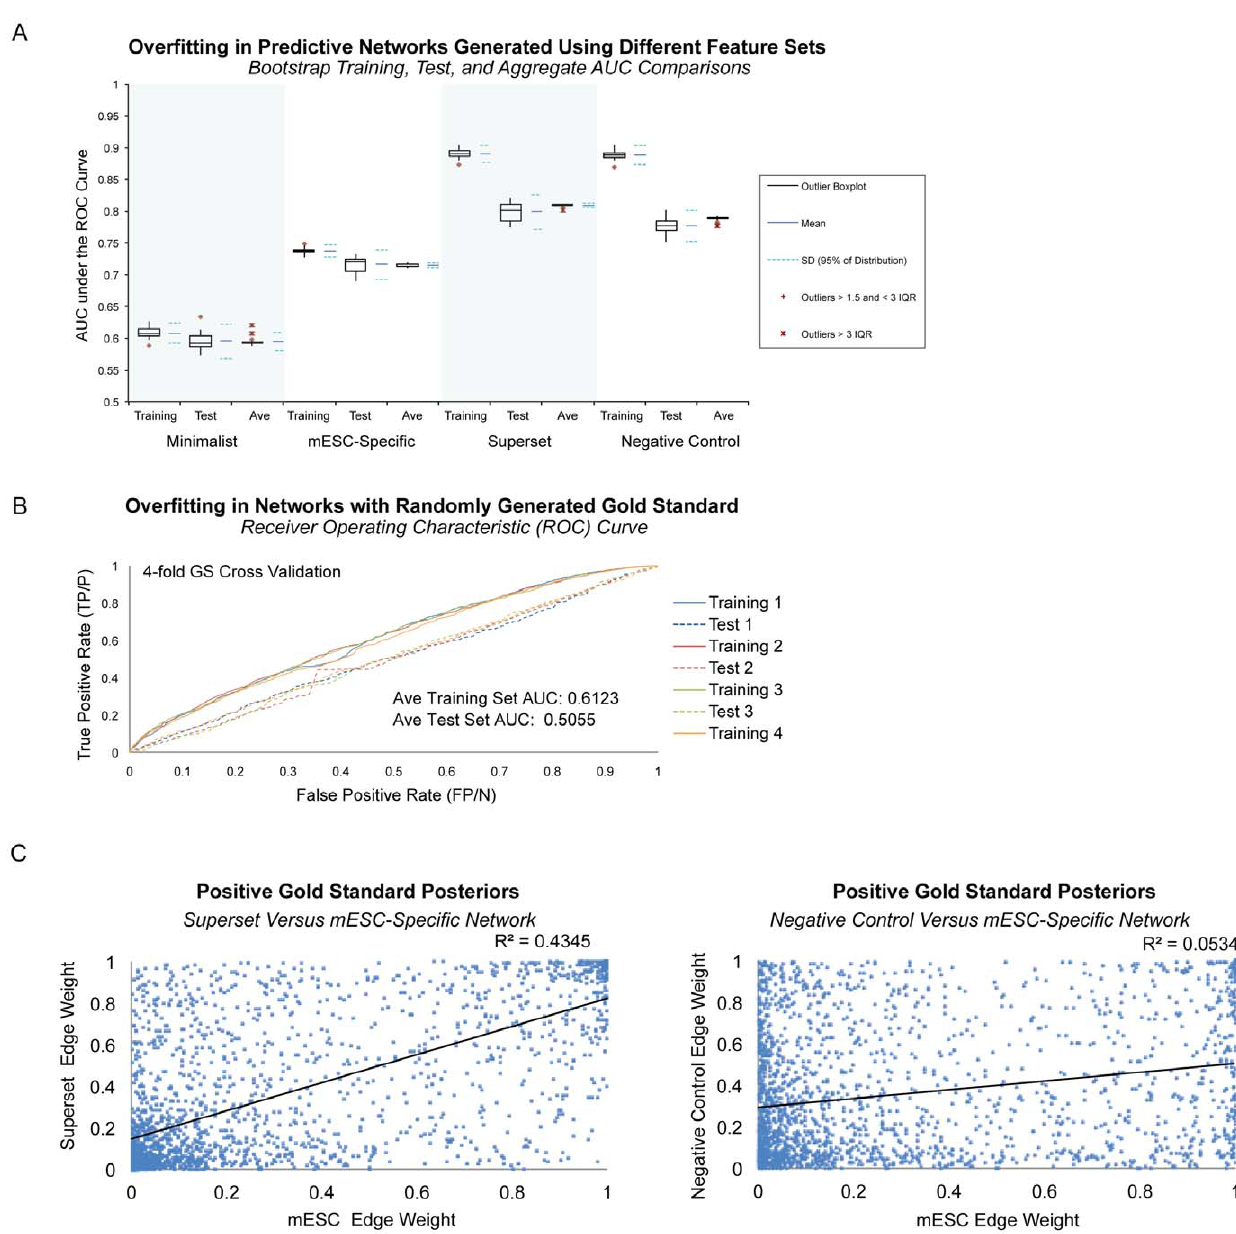
Figure 5. Importance of Feature Selection in Bayesian Network Machine Learning. A. Networks trained using the same mESC gold standard but different feature sets had markedly different evidence of overfitting. We generated networks using three different feature sets: a minimalist library of 16 datasets composed largely of non-cell-type-specific data from molecular interaction databases, our mESC-specific compendium composed of 164 datasets restricted to mouse mESC data and a small amount of data not specific to any cell type, a superset compendium composed of all mESC training data plus an additional 646 non-tissue specific mouse microarrays, and a negative control compendium containing all datasets except those with mESC data. Using machine learning metrics, we found that the network trained on a small amount of non- tissue-specific data achieved the lowest ROC curve AUCs and had the least amount of overfitting. The mESC-specific network achieved a higher AUC, and showed evidence of minimal overfitting. The superset and negative control networks had the highest AUCs, but also showed extreme overfitting with a difference of greater than 0.1 between training and test set AUCs. Bootstrapping followed by out of bag averaging largely correct for overfitting in the mESC-specific, superset, and negative control networks. However network content varied dramatically. B. Overfitting in Networks with Randomly Generated Gold Standards. Networks trained on randomly generated gold standards performed better than random according to standard machine learning metrics, but 4-fold cross validation revealed these networks had evidence of overfitting that could be corrected for using regularization and bagging techniques. C. Evaluating Network Differences using Positive Gold Standard Posteriors. A scatterplot of superset versus mESC-only network positive gold standard posterior edge (those with a prior of 1) illustrates that while there is relatively high correlation (Pearson correlation r=0.6592), there is also a broad range of disparity between the two networks. A scatterplot of negative control versus mESC shows that there is less correlation between the two networks (Pearson correlation r=0.2311), and reveals the subset of the training gold standard supported by non-mESC data.